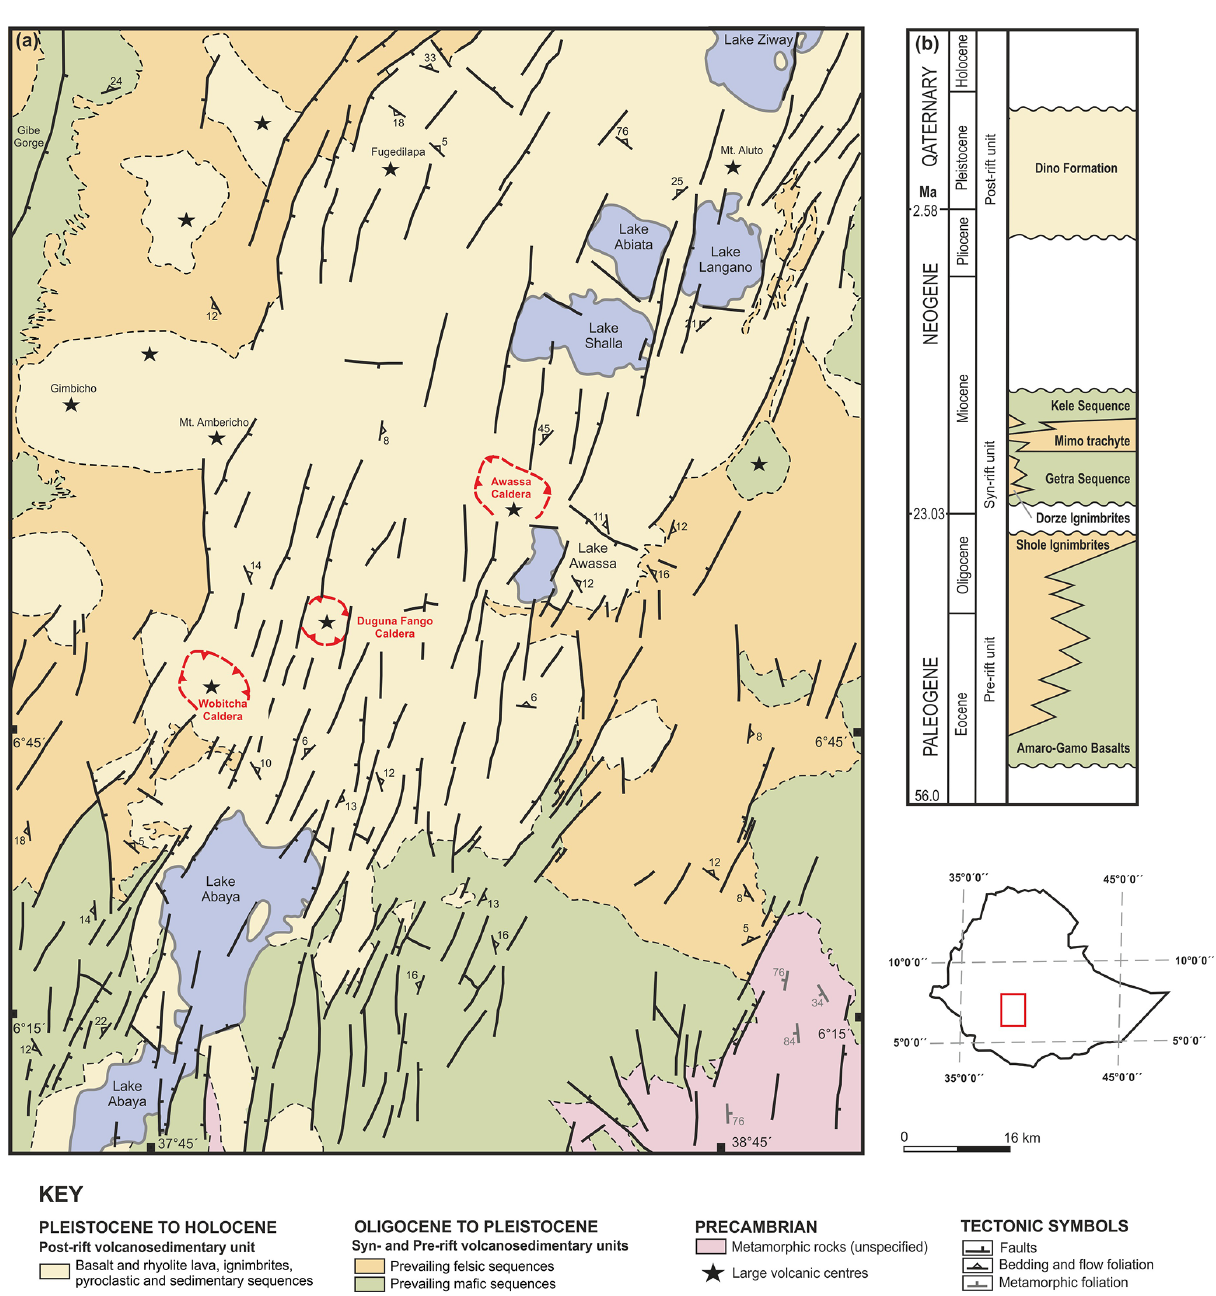
Figure 4. (a) Simplified geological map of the southern part of the Main Ethiopian Rift (Hossana and Dilla areas). (b) Schematic stratigraphic chart of the Main Ethiopian Rift (Dilla and Hossana areas). Compiled using unpublished geological maps (1 : 250000; Geological Survey of